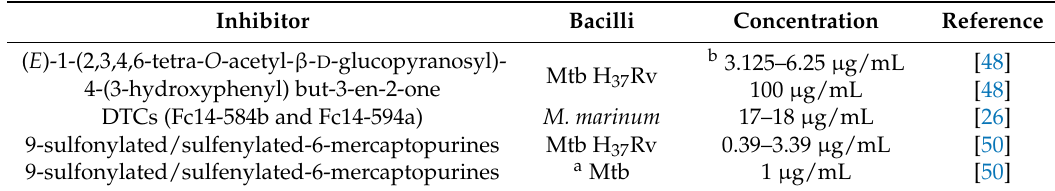
Table 3. Studies on minimal inhibitory concentrations (MICs) of the CA inhibitors in mycobacterial cultures.